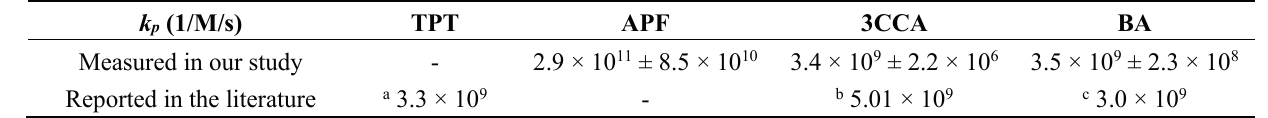
Figure 1. The association of the inverse concentration of molecular probes with inverse reaction rate. Regression equation for TPT is 1/ R p = (5.436 × 10 − 4 )/[ TPT ] + 0.5072, R 2 = 0.986 and APF is 1/ R p = (6.243 × 10 − 6 )/[ APF ] + 2.793, R 2 = 0.757. Table 1. Reaction rate constant of molecular